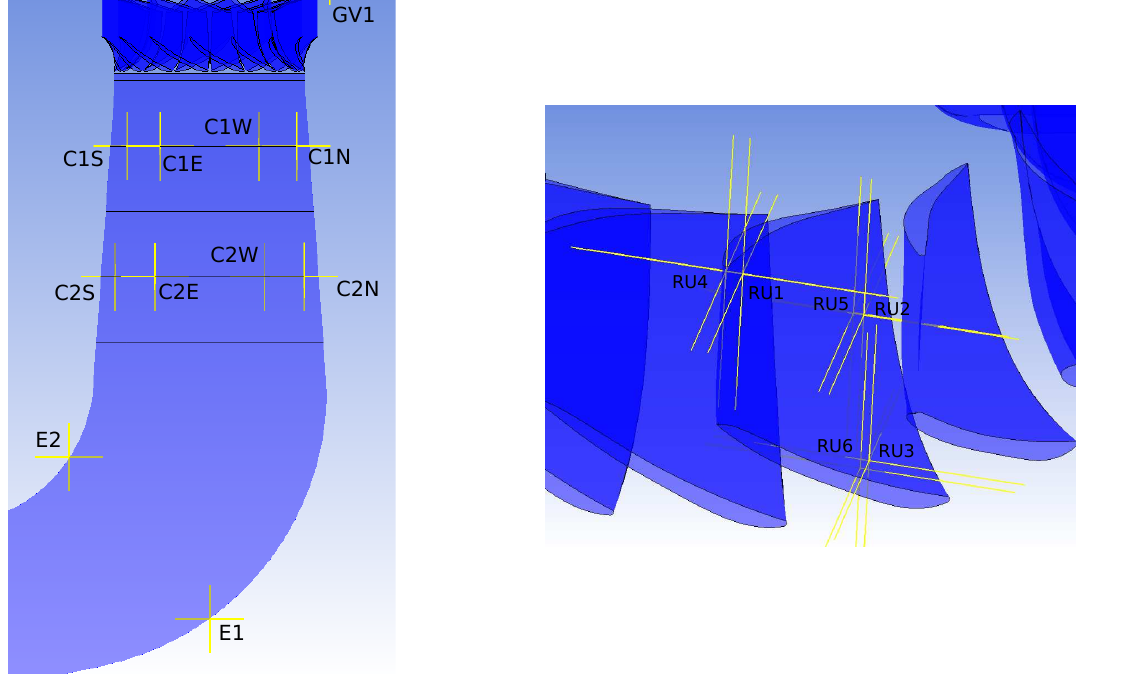
Figure 7. Positions of pressure probe in the computational domain (left). Zoom on the runner probe locations